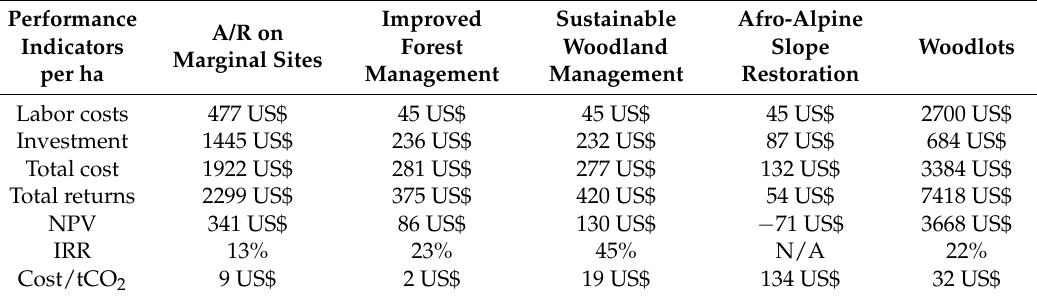
Table 2. Discounted costs and benefits for FLR transitions (1-ha models).